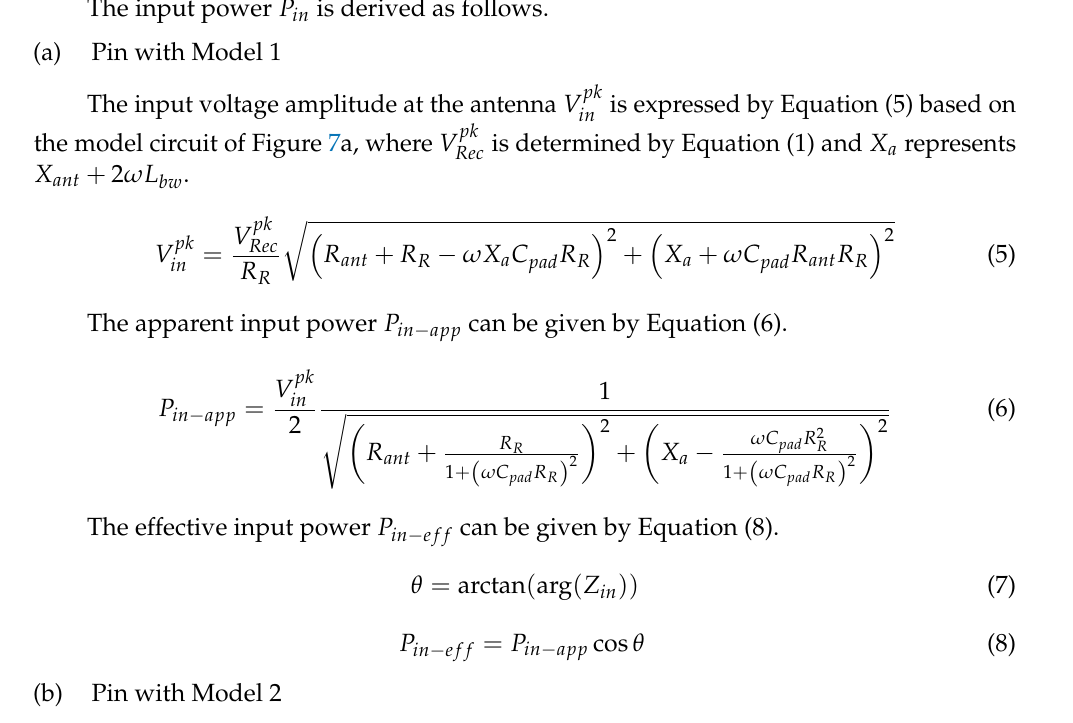
Figure 7. ( a ) Simple parasitic model (Model 1), ( b ) Detailed parasitic model (Model 2). The input power P in is derived as follows.